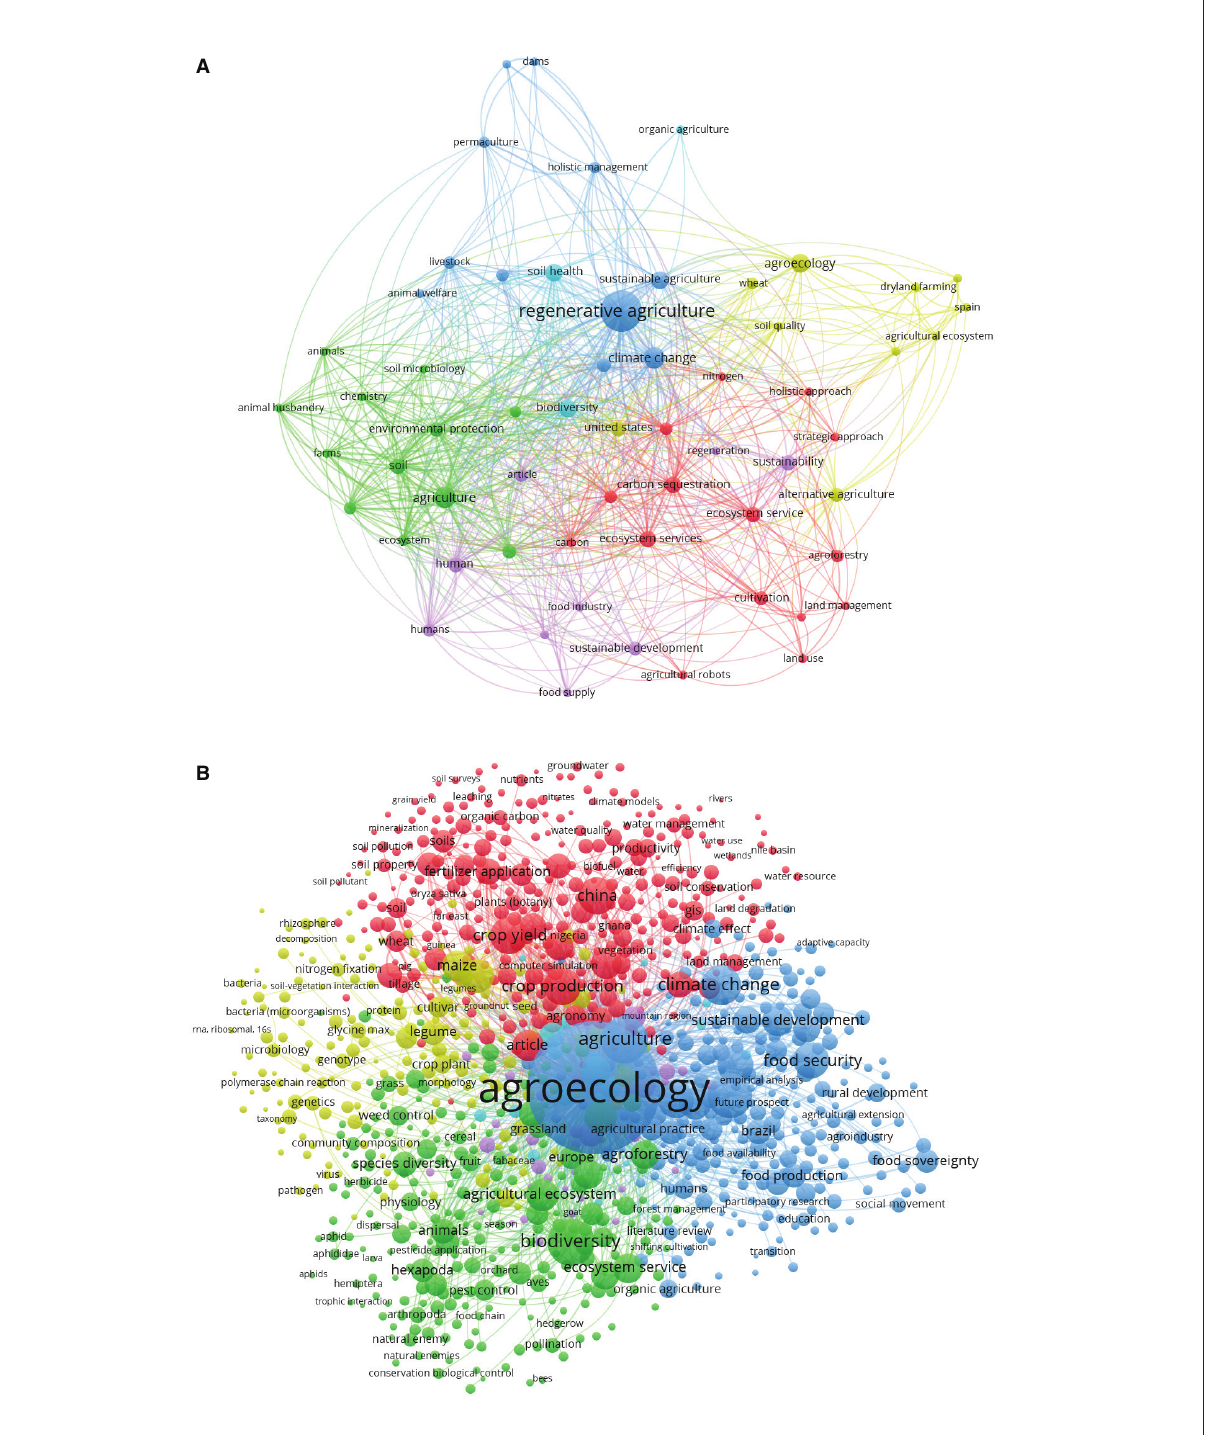
FIGURE4 Co-occurrence network of keywords from (A) 101 articles related to regenerative agriculture and (B) 4,426 articles related to agroecology. The network was based on a minimum of 5 co-occurrences between two terms, size of bubbles and text is proportional to term’s grade (number of connections), and thickness of connections to the number of